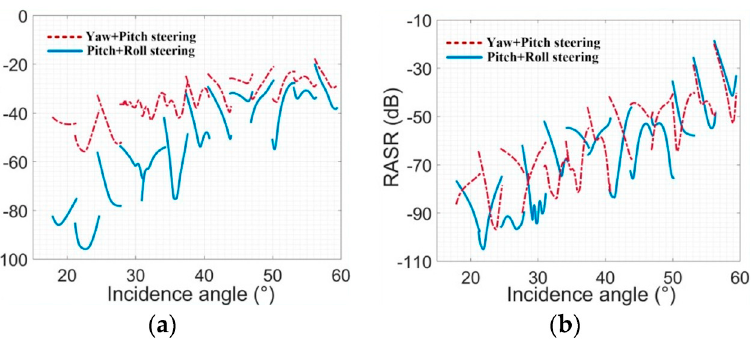
Table 1. Simulation parameters of GF-3 and Geo-SAR. Name